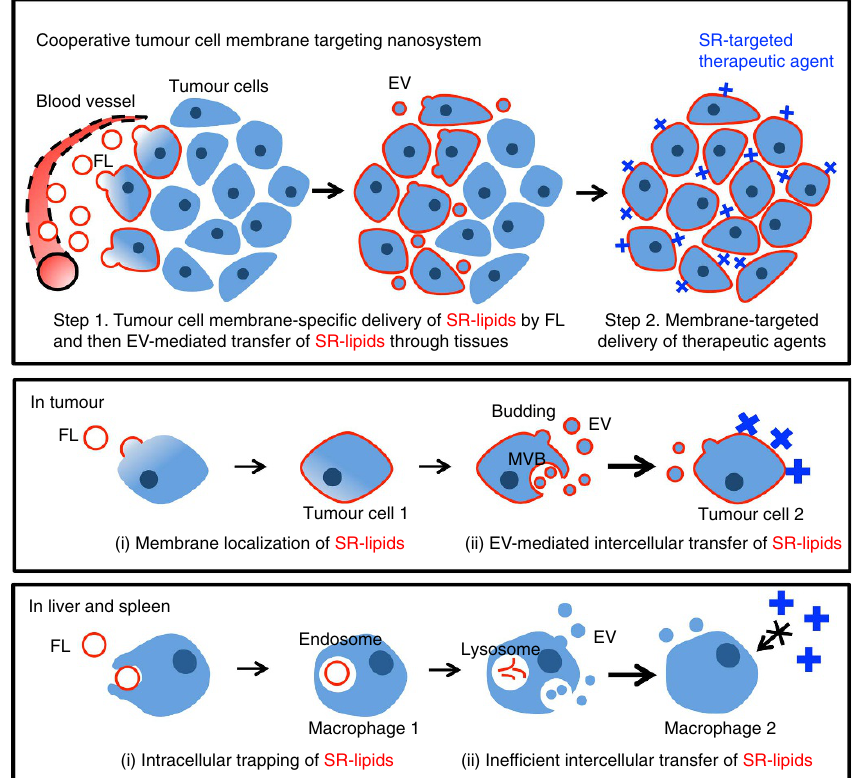
Figure 1 | Schematic representation of cooperative tumour cell membrane targeting nanosystem. In step 1, FLs are intravenously injected to deliver SR- lipid conjugates (SR-lipids, red) specifically to the plasma membranes of tumour cells in the perivascular regions. The SR-lipids are then incorporated into the membrane of EVs secreted from the cells, and transferred to the membranes of neighbouring cells via EVs. This active EV-mediated transfer of SR-lipids occurs through tumour tissues over 24h after SR-lipid injection. In step 2, SR-targeted proteins (blue) that are capable of tumour penetration due to their relatively small size are intravenously injected to deliver therapeutic agents to the tumour cells pretreated with SR-lipids. Importantly, FLs deliver SR-lipids efficiently to the plasma membranes in tumours for subsequent EV-mediated spreading, while FLs taken up by macrophages in the mononuclear phagocyte system undergo lysosomal degradation, minimally exposing the SRs on the macrophage surface.